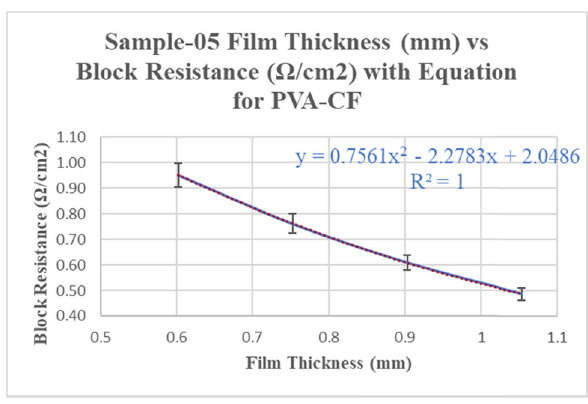
Figure 15: Sample - 05 ( CF:PVA = 1.0:30 ) block resistance ( Ω ) versus fi lm thickness ( mm ) with equation for PVA - CF. The dotted lines represent the polynomial fi tted curve and the linear fi tted curve.